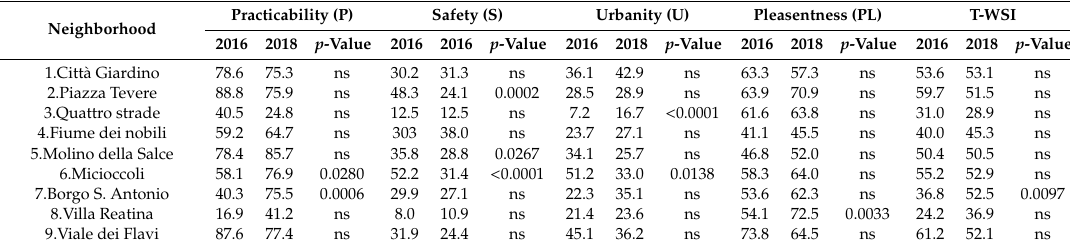
Table 4. Comparison and significance di ff erences among indexes and the Walking Suitability Index of the territory (T-WSIs) obtained in each neighborhood in 2016 and 2018